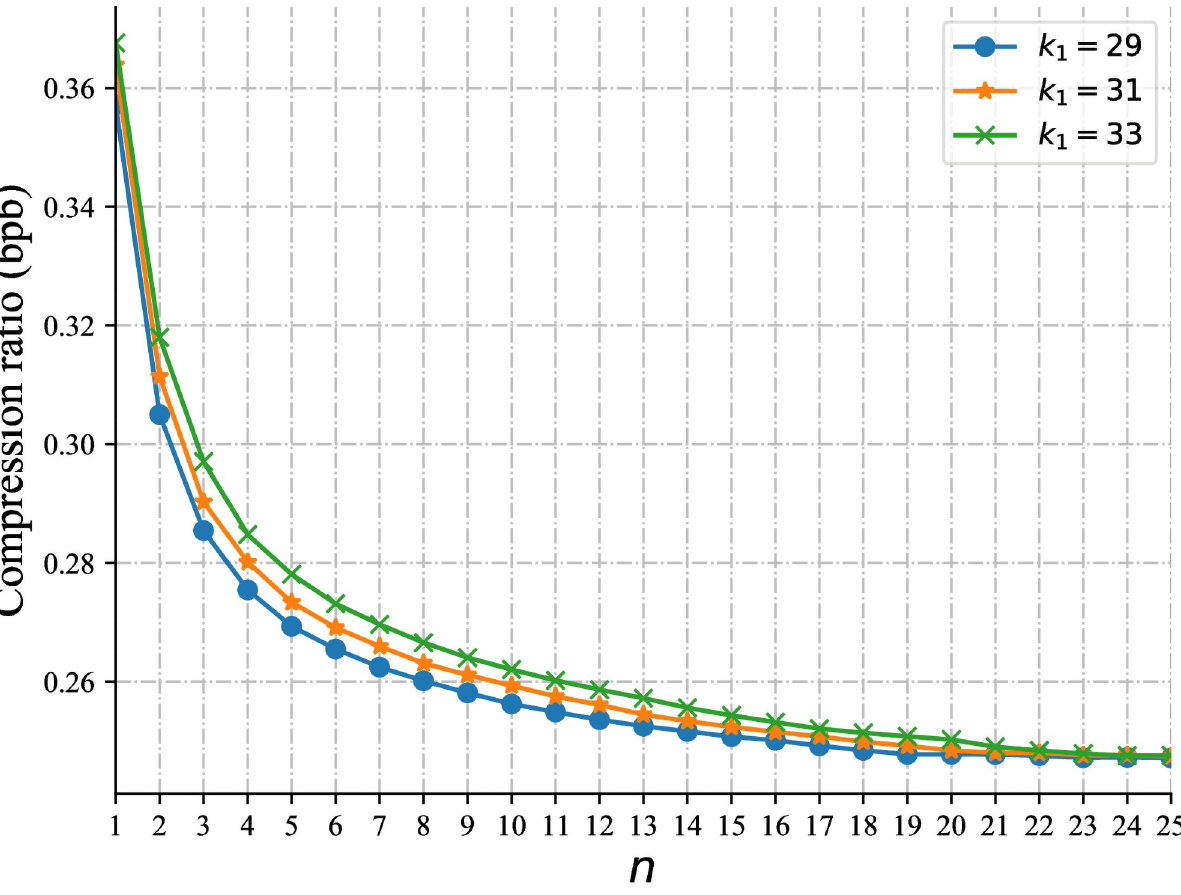
Fig 4. Compression ratios under different settings of k 1 and n